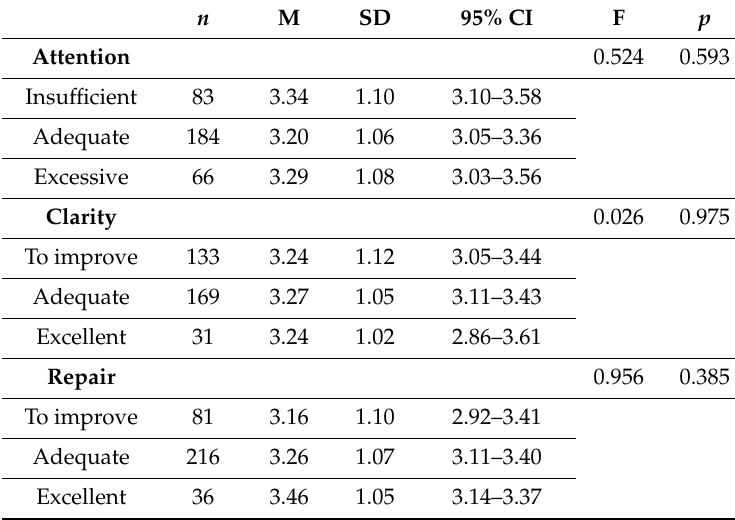
Table 4. Comparison of means in academic performance based on the emotional Attention, Clarity, and Repair dimensions.